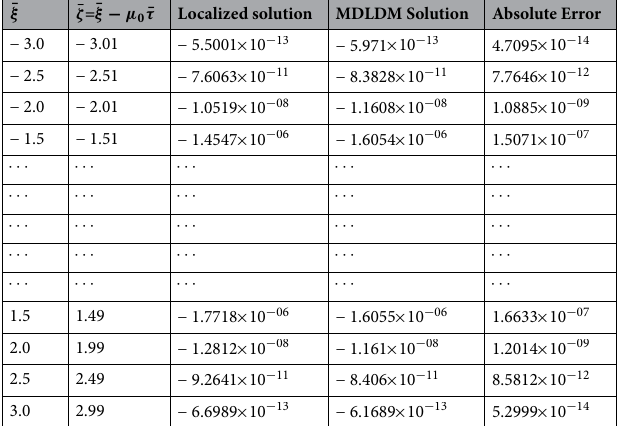
Table 2. Comparison of localized solution with approximate solution for µ 0 = 1 ,and ¯ τ = 0.01 .